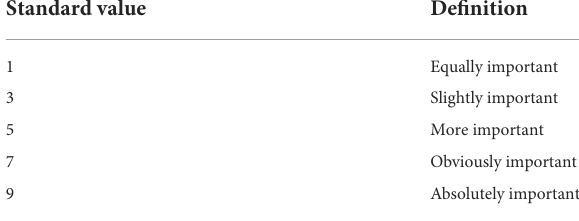
TABLE 2 Analytic hierarchy process (AHP) matrix scale and